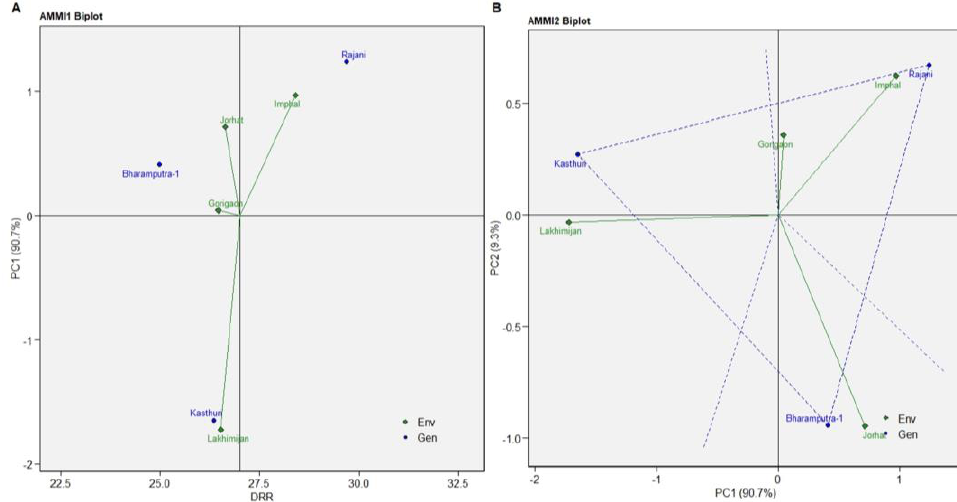
Figure 4. ( A ) AMMI1 biplot ( B ) AMMI2 biplot for number of mother rhizomes. The dry rhizome recovery of Bharamputra-1 was found to be less than those of Kasthuri and Rajani but showed stability in all MLTs (Figure 5A). As predicted in AMMI2 biplot, DRR of Bharamputra-1 was highest in Jorhat while those of Rajani in Imphal and Gorigaon, and Kasthuri in Lakhimijan (Figure 5B).